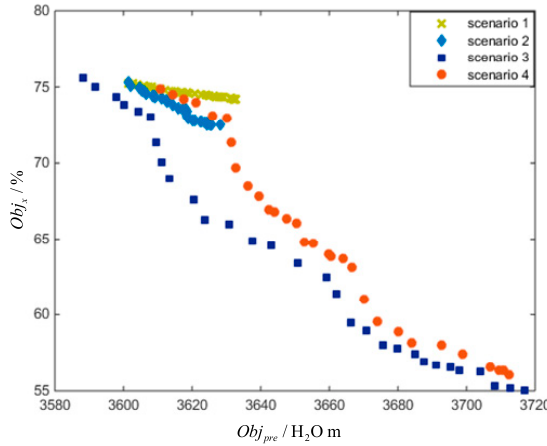
Figure 9. The Pareto front obtained by different scenarios under load rejection.